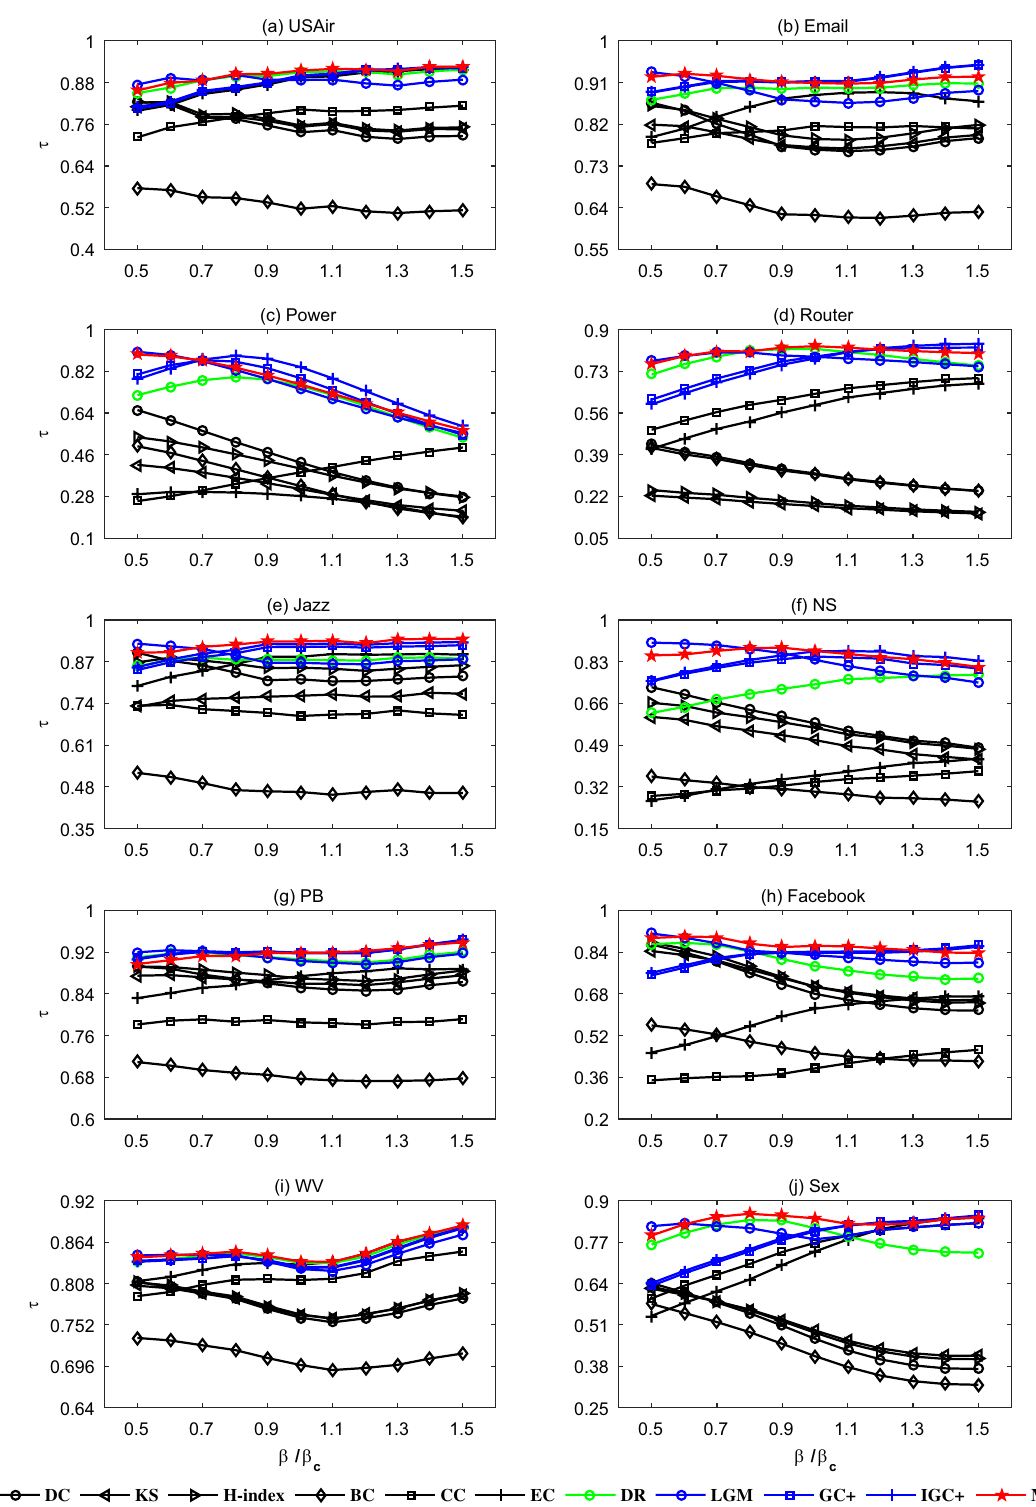
Figure 2. The algorithms’ accuracies measured by Kendall’s Tau for different β . The six classic algorithms (DC, H-index, KS, EC, BC and CC) are represented by black symbols, DR is represented by green symbols, the typical algorithms based on the gravity law (GC+, IGC+ and LGM) are represented by blue symbols, MCGM is represented by red